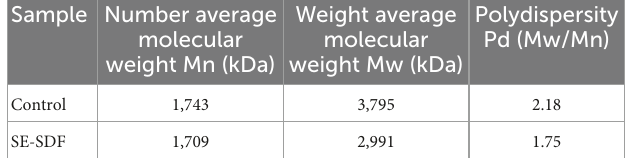
Sample Number average molecular